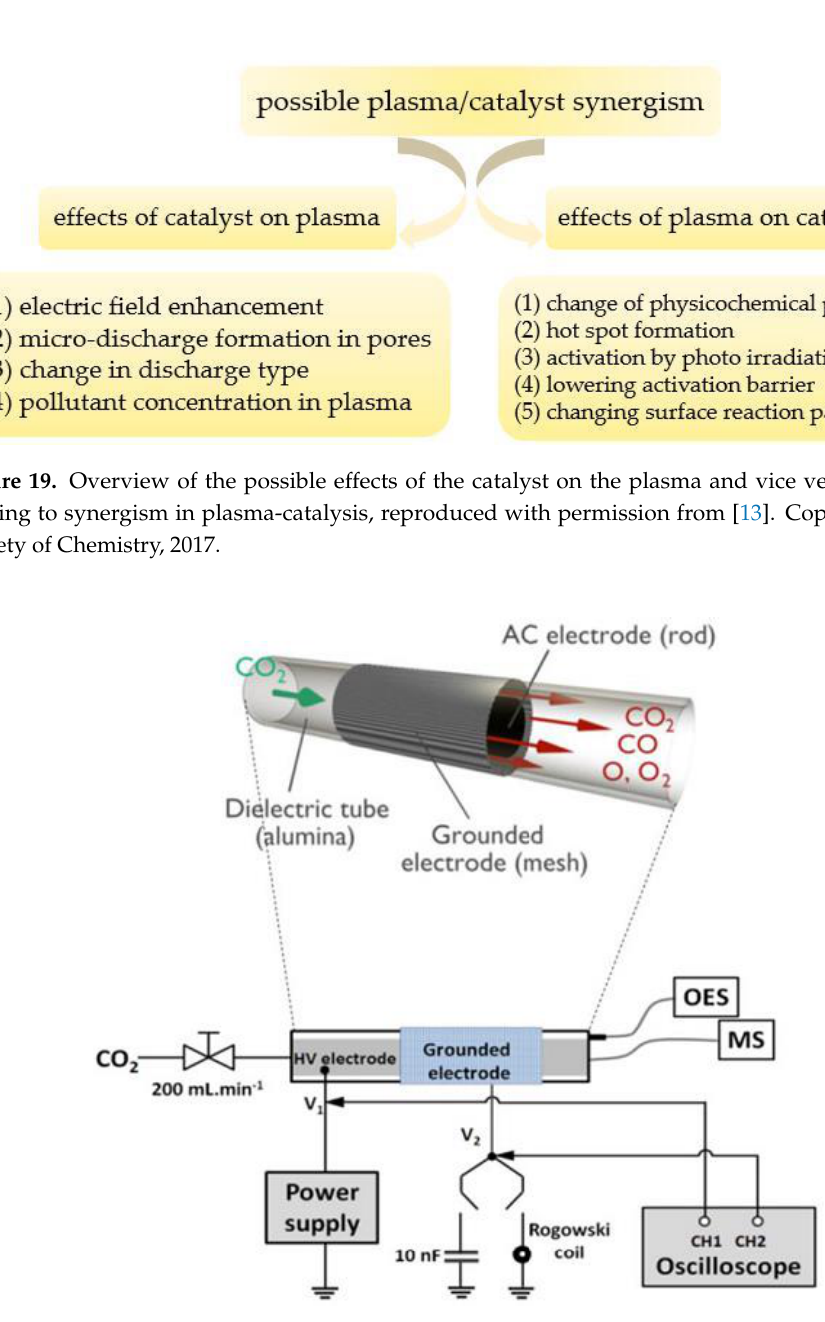
Figure 20. Schematic diagram of the experimental set-up used in the decomposition of CO 2 , reproduced with permission from [116]. Copyright IOP Publishing, 2016.